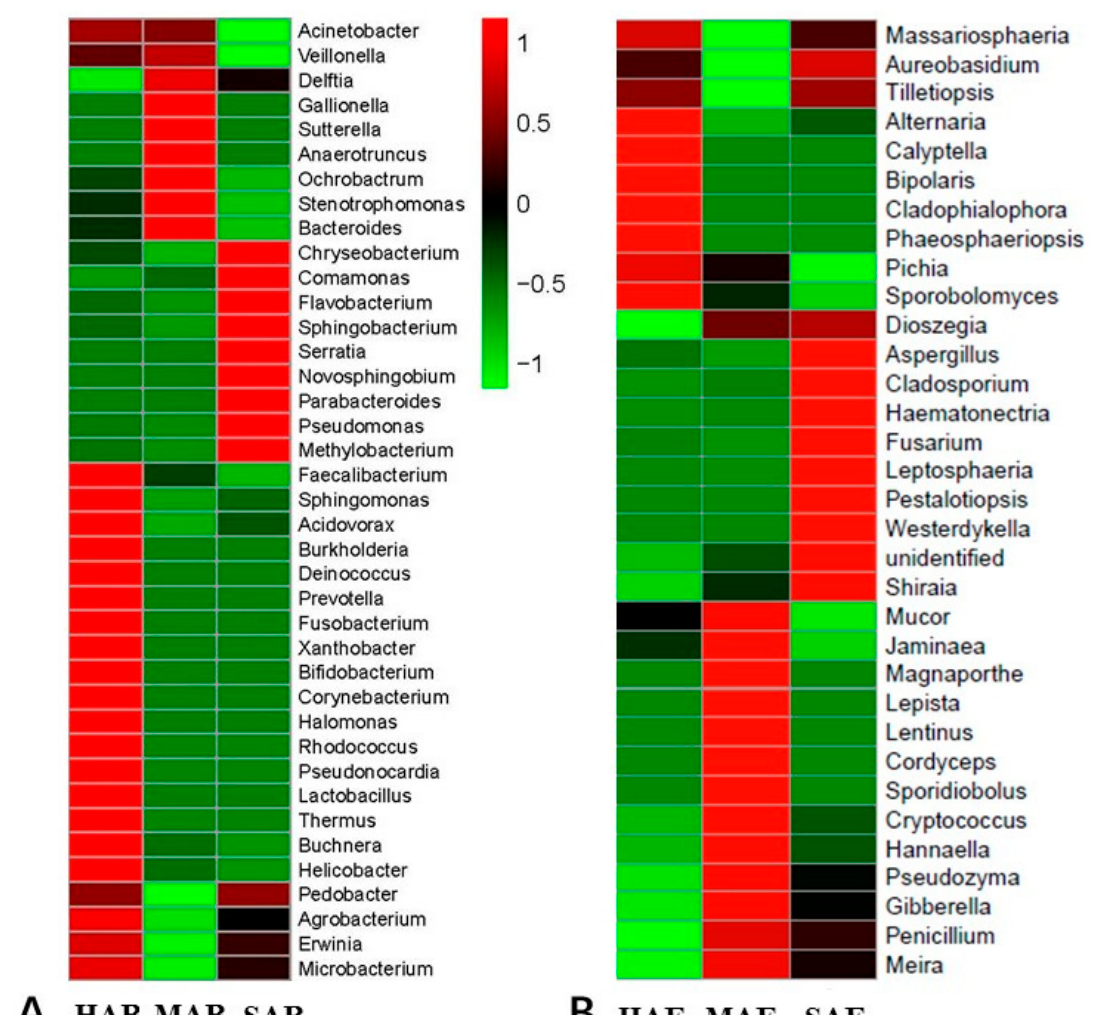
Figure 2. Relative composition of different bacterial ( A ) and fungal ( B ) orders in three aphid condi- tions. HAB and HAF indicate healthy aphids, MAB and MAF mycotized aphids, and SAB and SAF starved aphids.